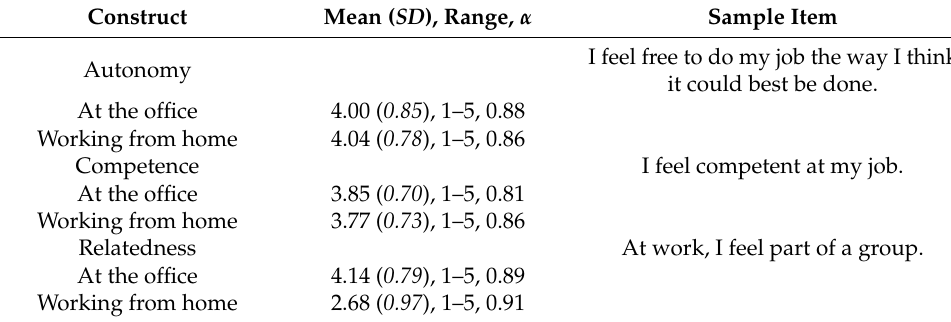
Table 1. Work-related basic needs satisfaction items (2.2.1).